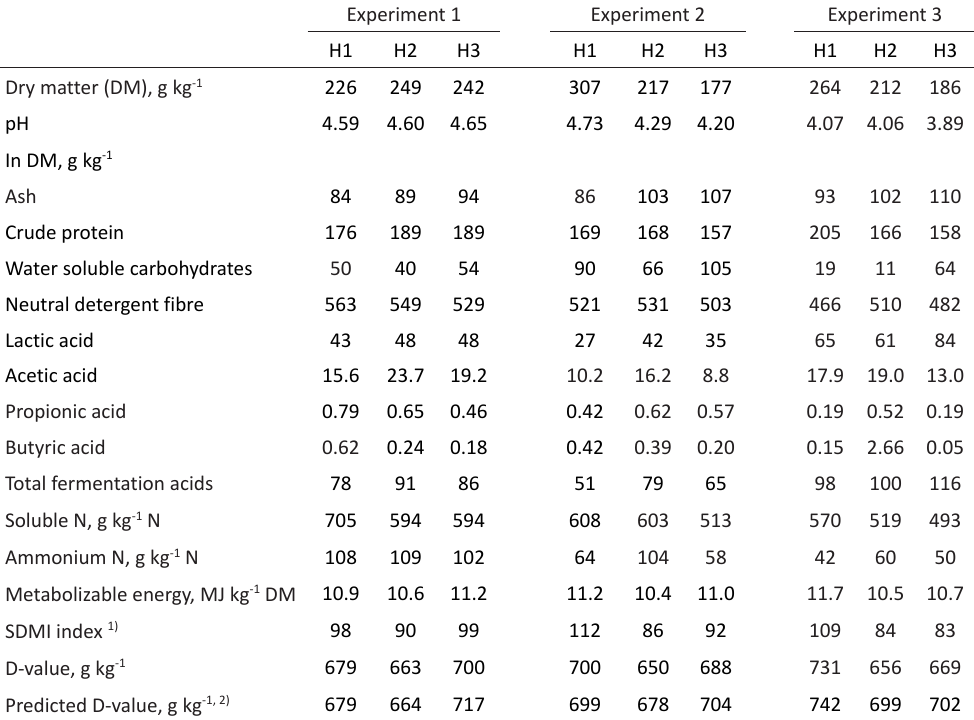
Table 3. Chemical composition of the first (H1), second (H2) and third cut (H3) grass silages across different